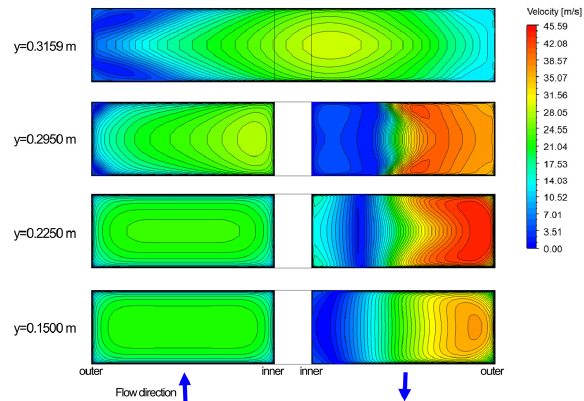
Figure 7. Velocity contour at di ff erent heights (Re = 24,230).